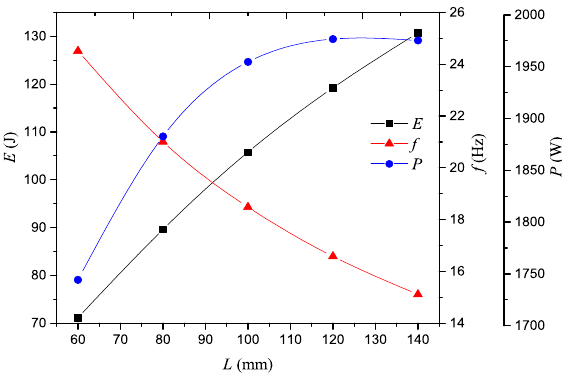
Figure 10. Variations of E , f and P versus stroke of the impact body L .